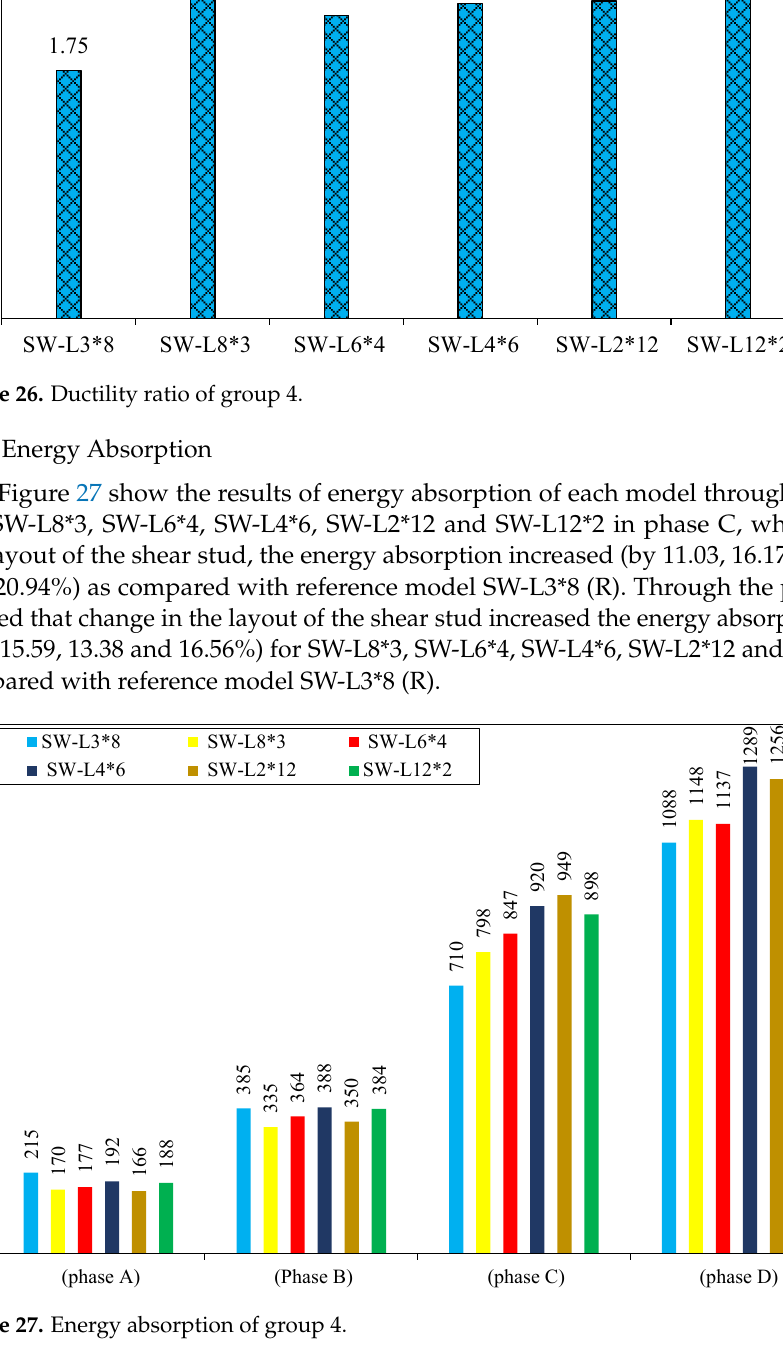
Figure 27. Energy absorption of group 4. Models with layout (12 × 2) (horizontal × vertical) (SW-L12*2) have excellent energy absorption, due to the high area under the curve of load-deflection, and this refers to an increase in the resistance of the model to the deformation. From the results of stiffness, ductility and energy absorption, it is noticed that the layout of the shear stud should be a concentrated distribution of the vertical to the horizontal direction, because large distances will cause widespread buckling of the steel plate in free subpanels between shear studs and would result in no improvement. Therefore, the layout of the shear stud was (12 × 2, 6 × 4) (horizontal ×